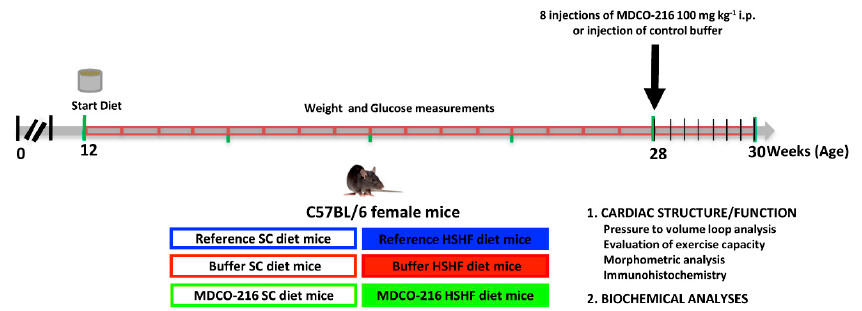
Figure 2. Schematic representation of the study design.